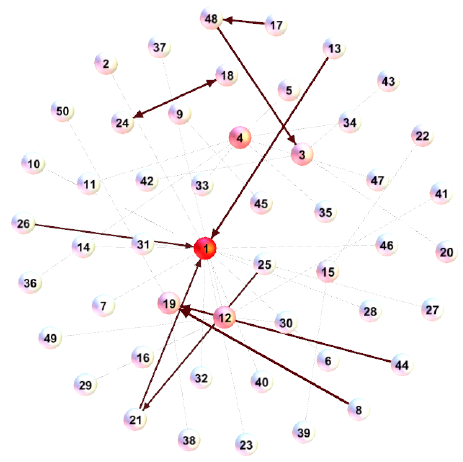
Figure 16. The spatial structure graph for F01 at generation 100.